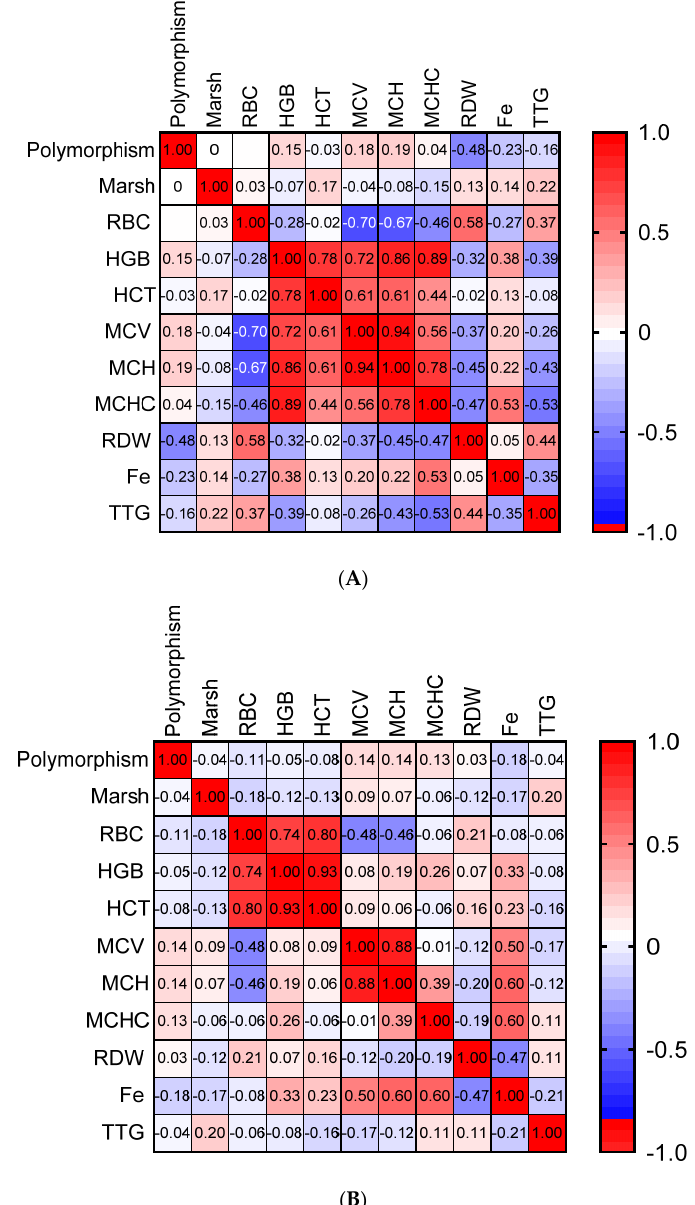
Figure 2. Heatmap representation of the correlations between anemia-related parameters at CD diagnosis in children with ( A ) and without ( B ) anemia. Marsh—Marsh classification; RBC—red blood cells; HGB—hemoglobin; HCT—hematocrit; MCV—mean corpuscular volume; MCH—mean corpuscular hemoglobin; MCHC—mean corpuscular hemoglobin concentration; RDW—red cell distribution width; Fe—iron; TTG—auto-antibodies directed against tissue transglutaminase 2.